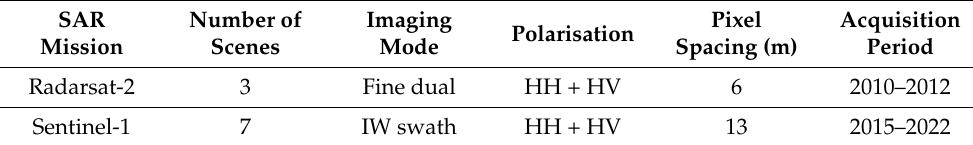
Table 1. Overview of the satellite SAR data